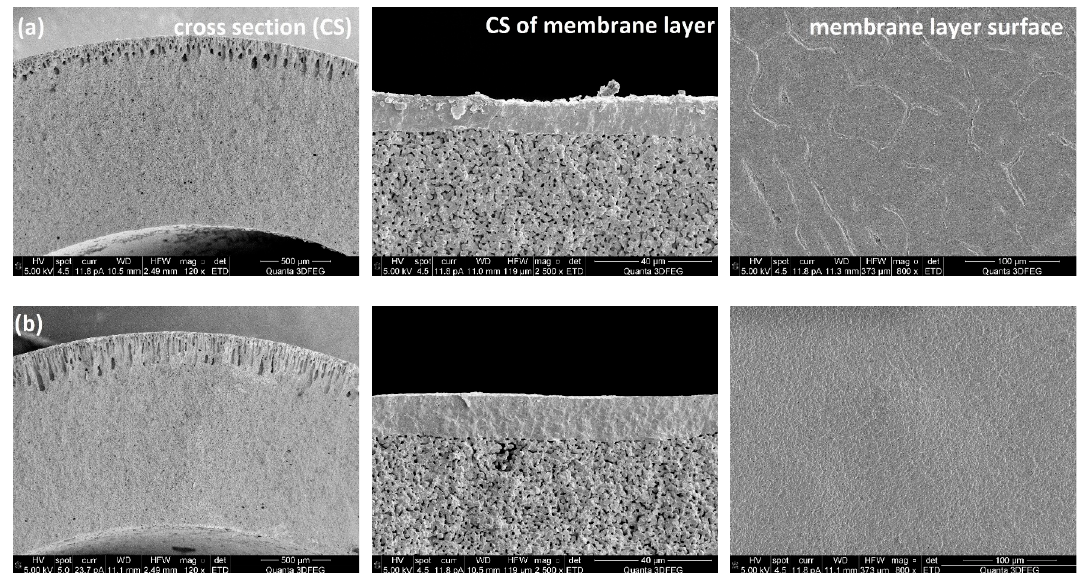
Figure 4. Element distribution on the cross section of the CGO-MgO dual-phase supported membrane: ( a ) Combined mapping and SEM image; ( b ) Combined element mapping; ( c ) Mg mapping; ( d ) Ce